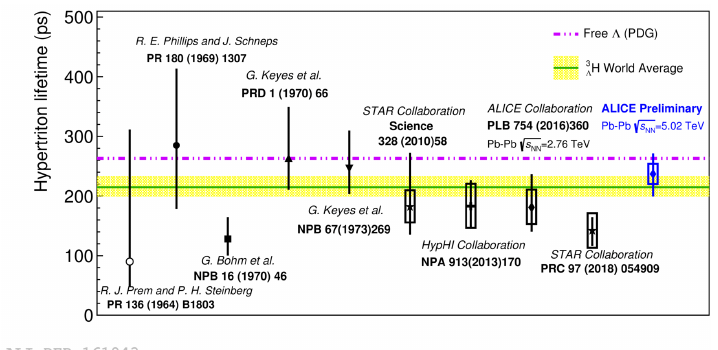
Figure 4. Collection plot of hypertriton lifetime measurements. In blue the latest ALICE results, which is the most precise measurement ever